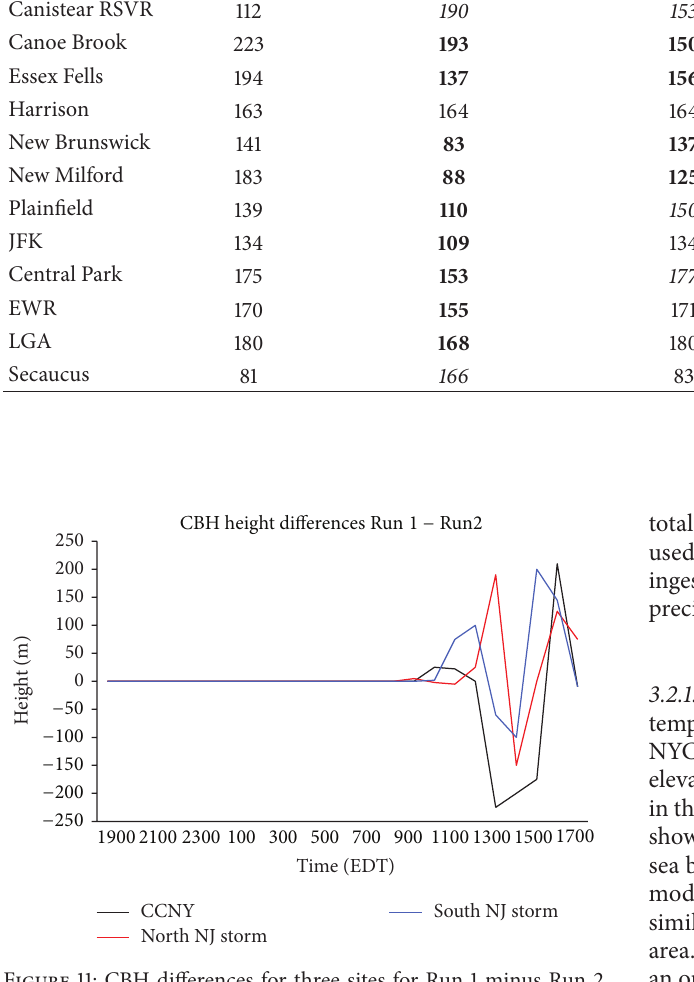
Figure 11: CBH differences for three sites for Run 1 minus Run 2 (HVFM–HVCM, City Case) within the region of